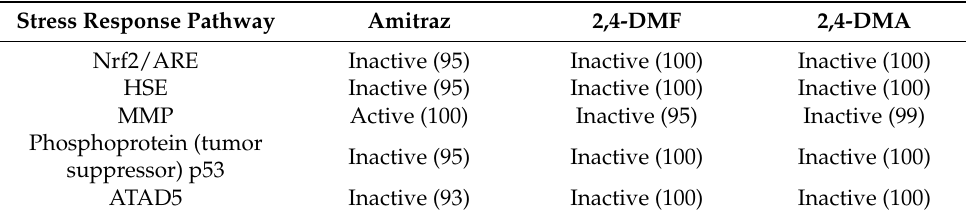
Table 4. Prediction of Tox21- Stress response pathways of amitraz and its metabolites. Stress Response